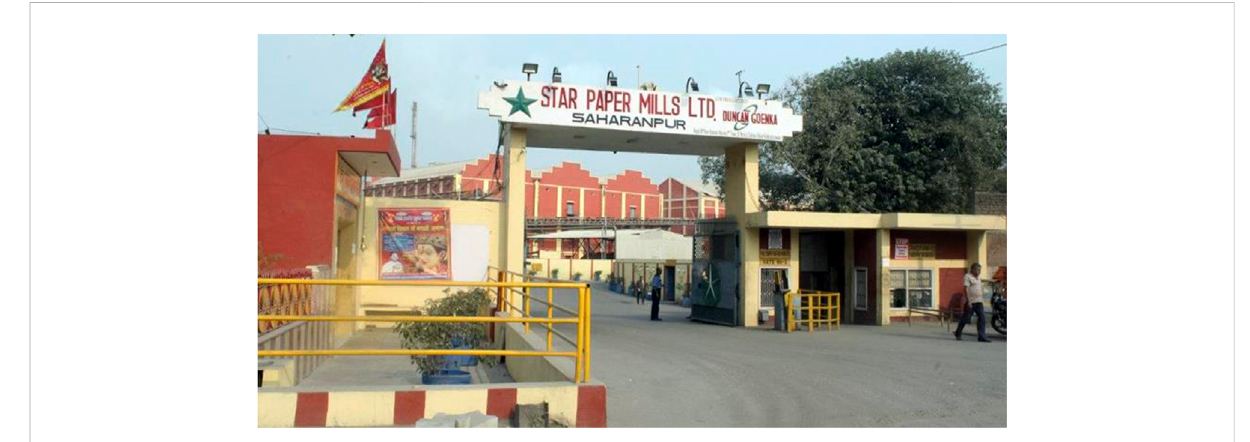
FIGURE 3 Selection of study area (Star Paper Mills Ltd., Saharanpur, UP, India).